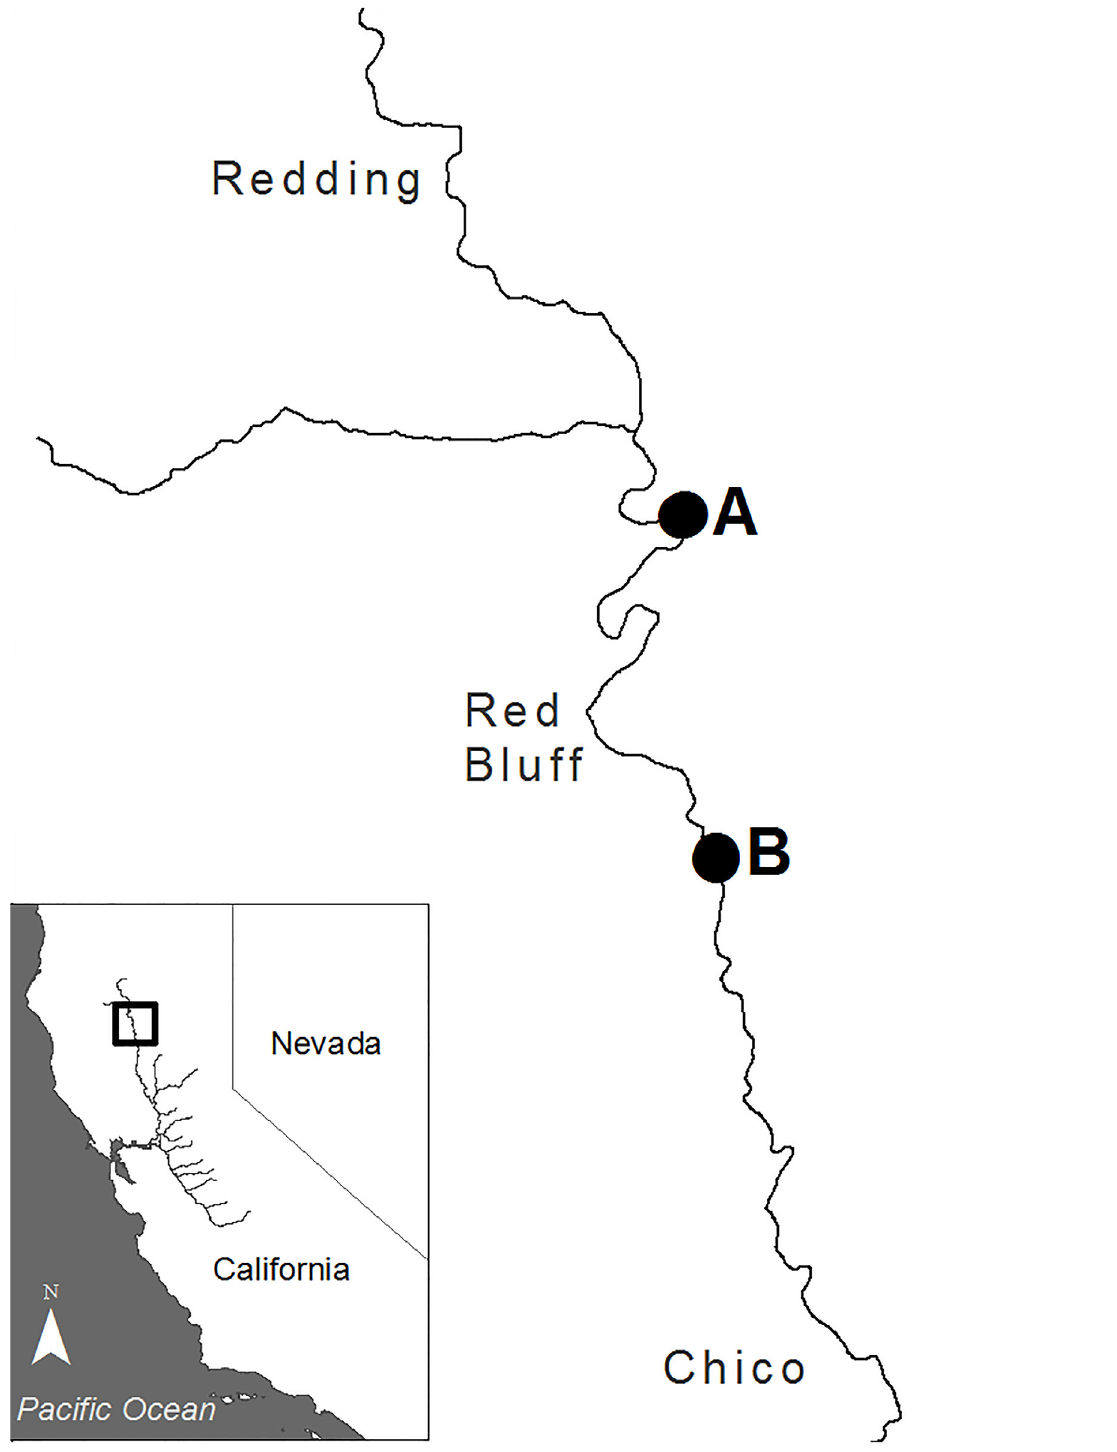
Fig 1. Environmental DNA sampling locations on the Sacramento River, CA.